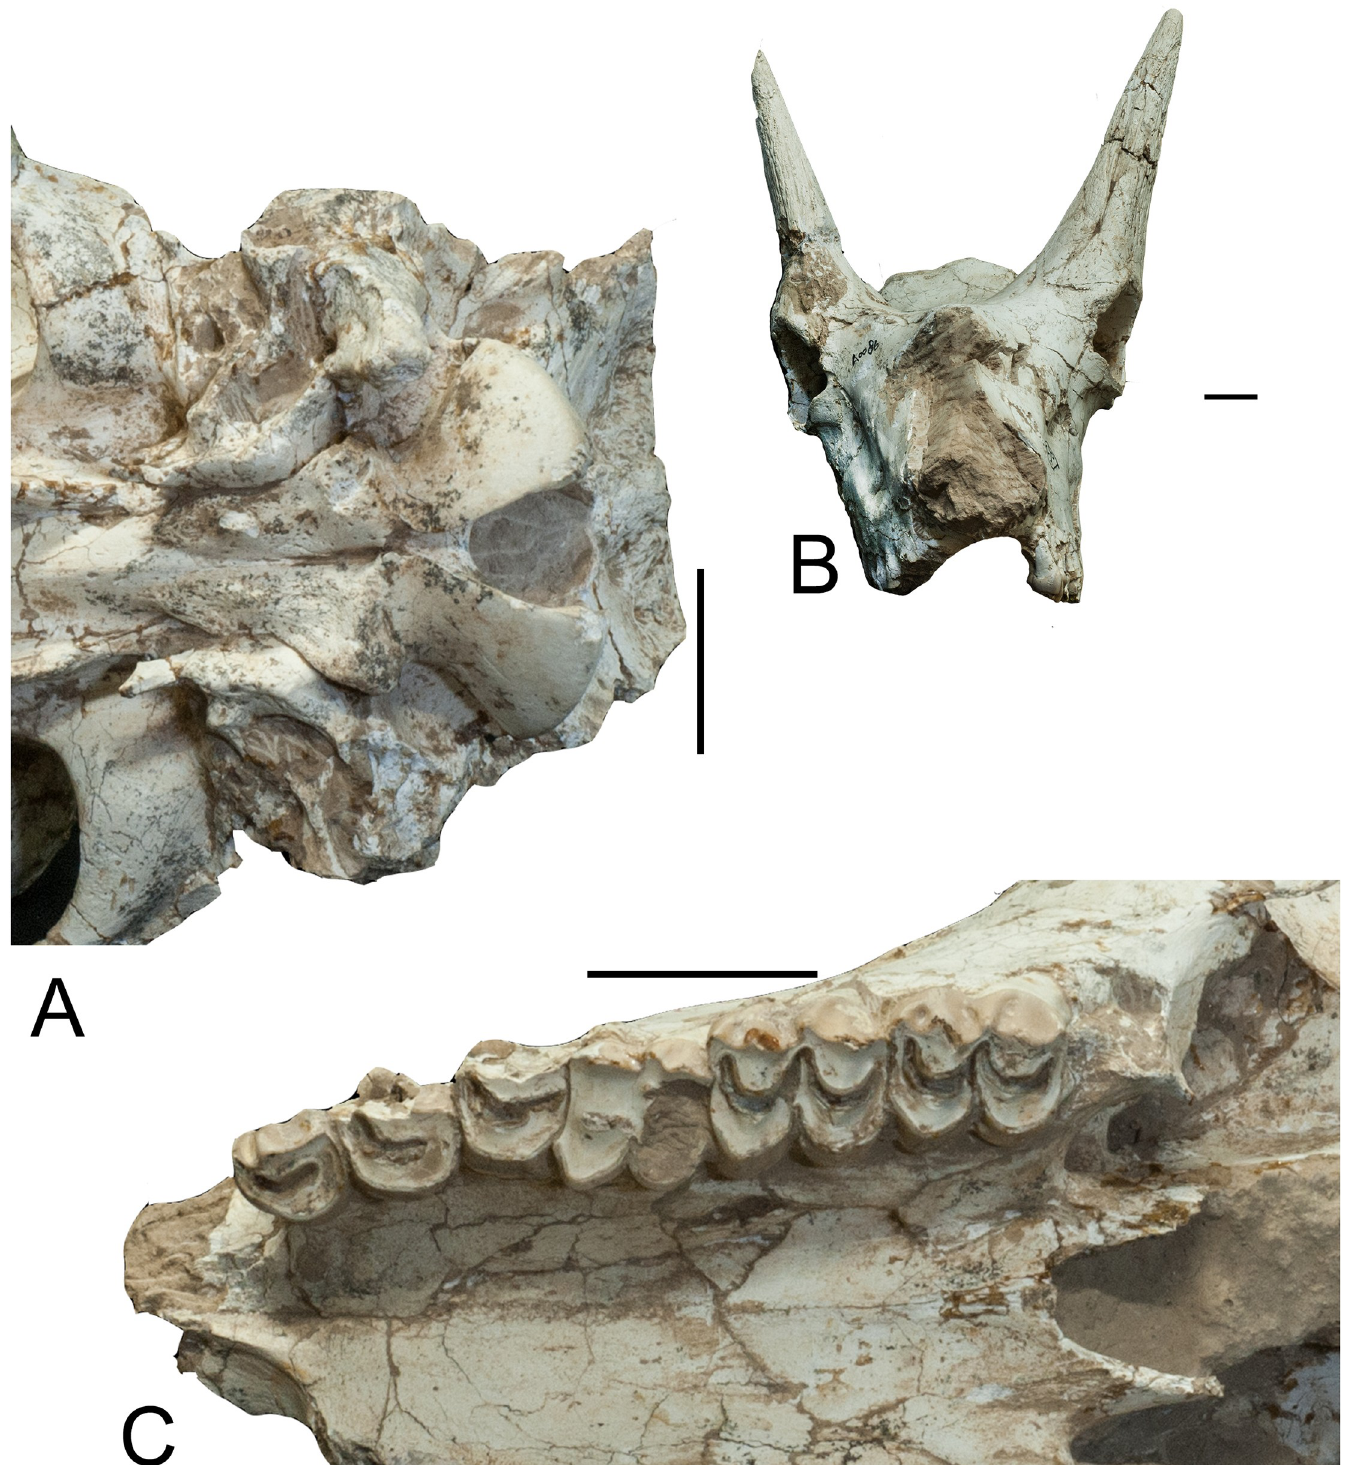
Fig 16. Samotherium boissieri. (A) Ventral aspect of braincase HMV IVPP V20271. (B) Anterior aspect of skull. (C) Upper dentition. Scale 50mm.